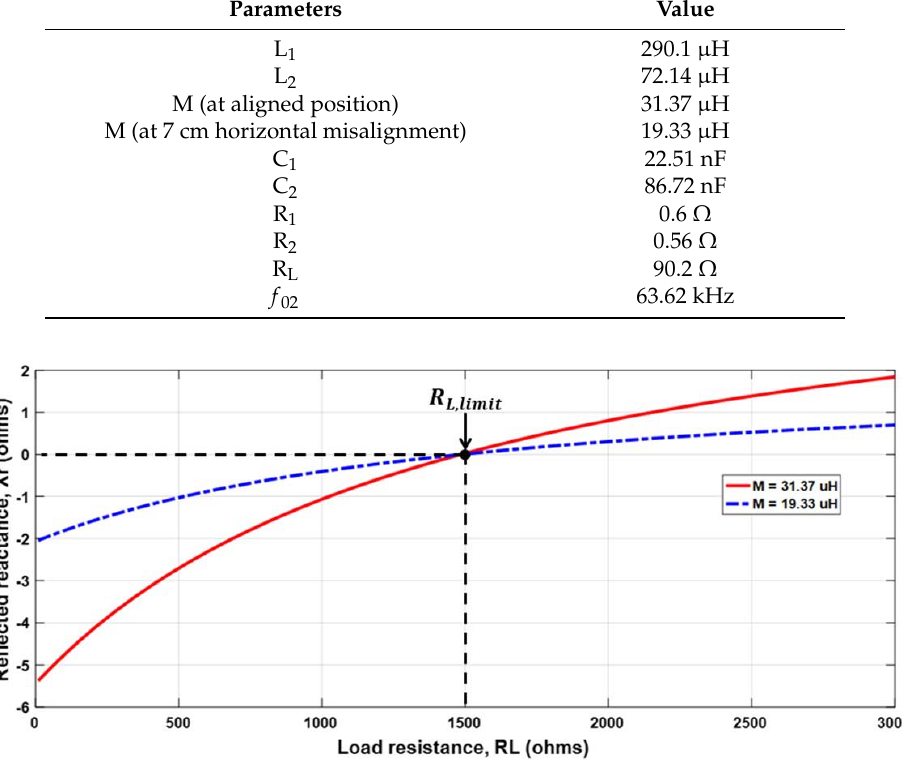
Figure 3. The plot of reflected reactance against load resistance for different mutual inductance.